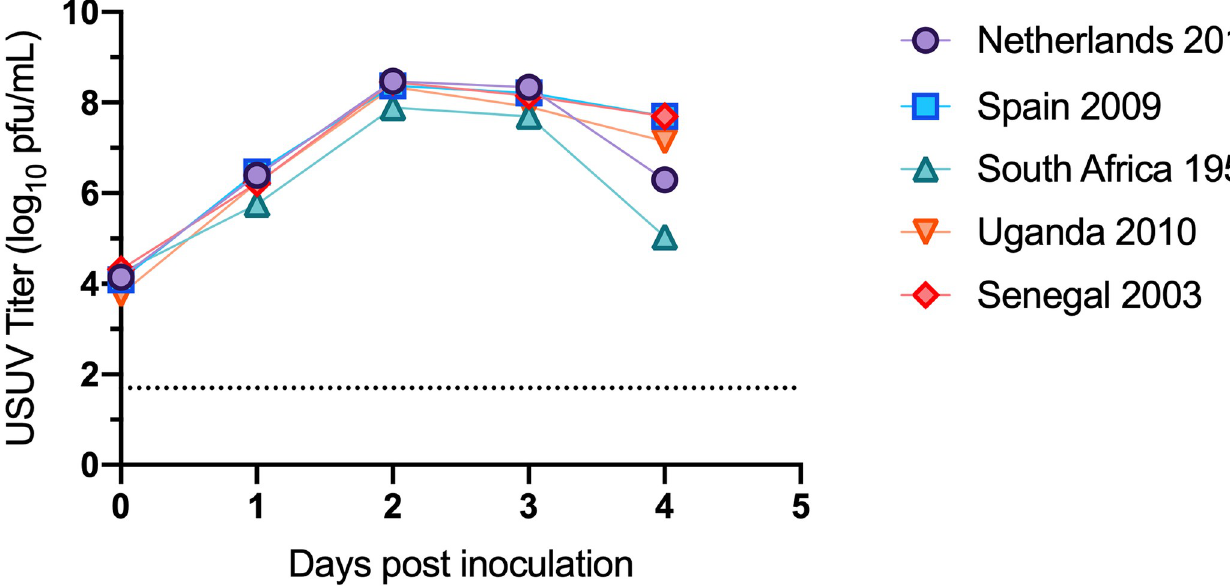
Fig 1. Growth kinetics of USUV isolates in Vero cells. Circles and error bars represent means and standard deviations, respectively, of triplicate inoculated cultures. Dashed line represents limit of detection. The growth curve was performed three times, with one representative experiment shown.